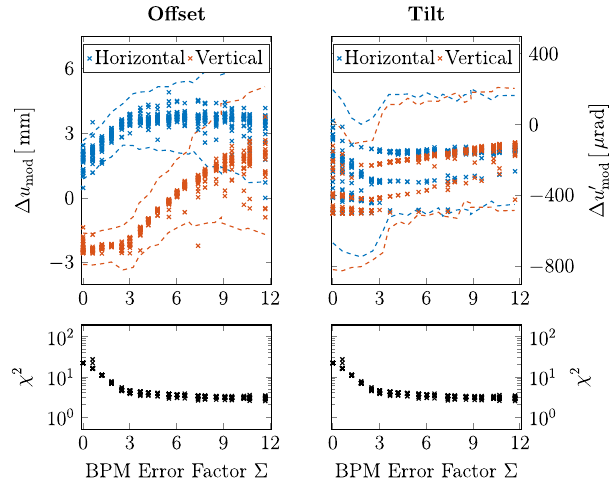
FIG. 10. Fitted offset (left) and tilt angle (right) of the injector module at FLASH for the horizontal (blue) and vertical (red) plane. The fit results (top) and the corresponding χ 2 (bottom) are plotted as a function of the BPM error factor Σ . Σ includes the calibration factor δ u and the error of the offset value Δ u in a fixed BPM BPM n · 30% and δ u ratio. Σ ¼ n corresponds to both, δ u BPM ¼ BPM ¼ n · 0 . 5 mm. The crosses are fitted solutions, while the dashed lines indicate the prediction accuracy based on